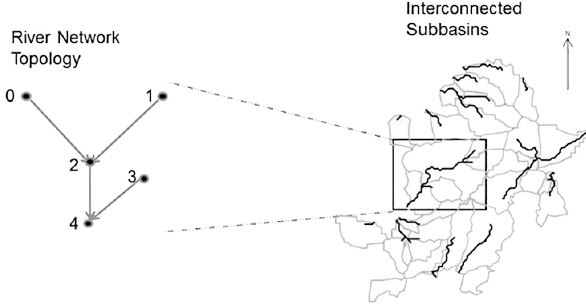
Fig. 2. Conceptualization of a river basin and a river network from Pande et al. (2011). Only hydrologic connectivity is